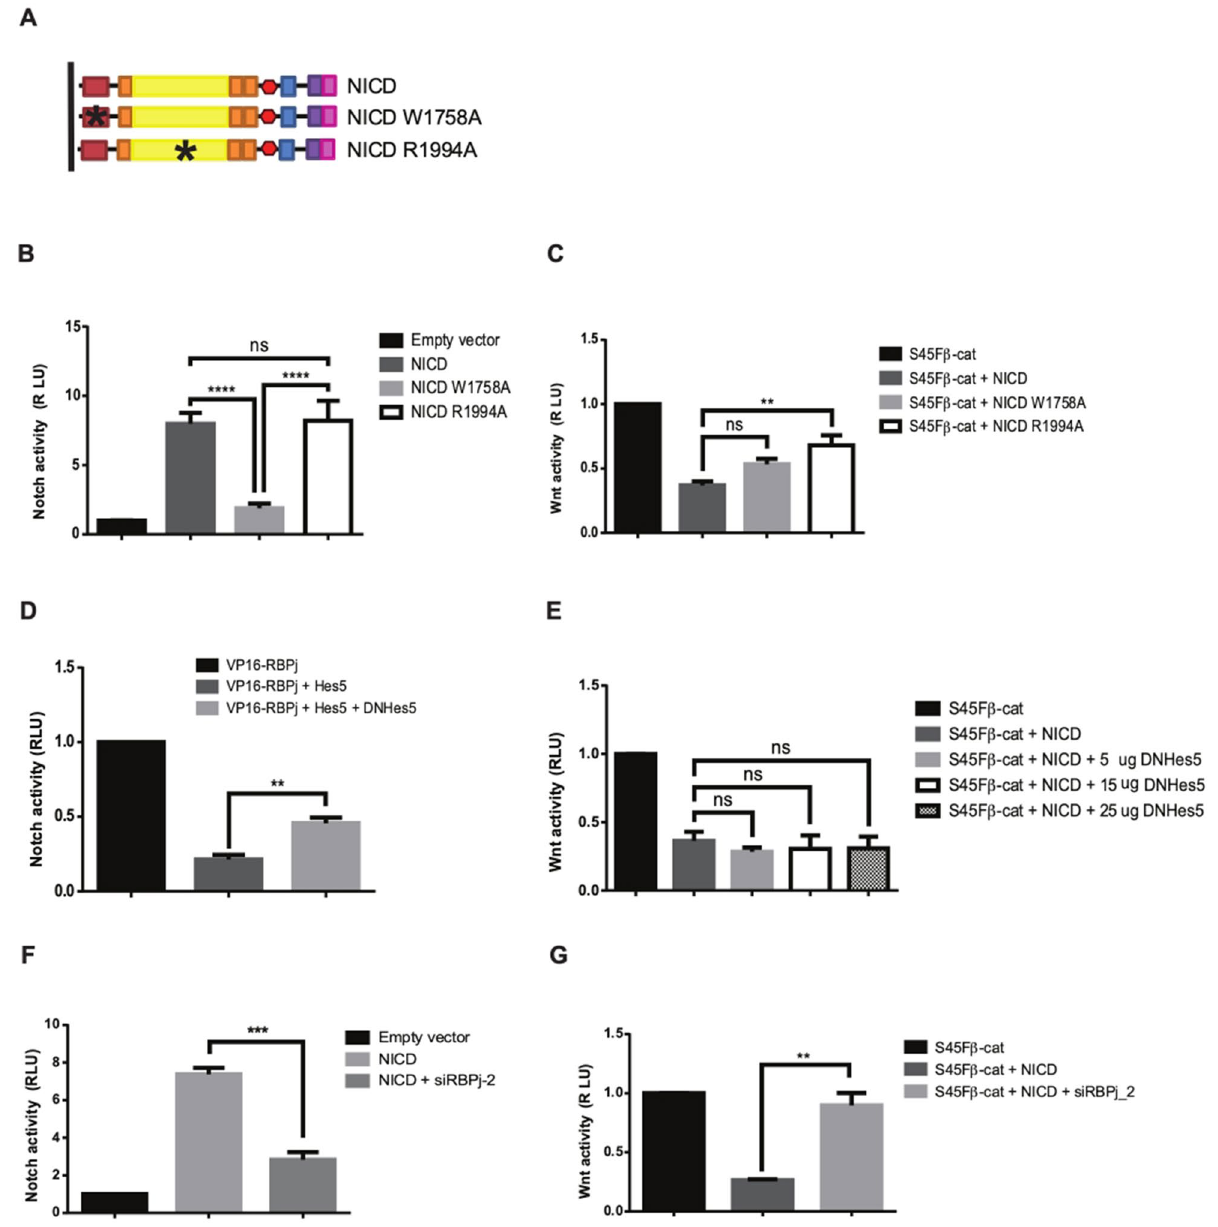
Figure 4. The inhibition of β-catenin-driven transcription by NICD does not require transcription of its downstream target genes. ( A ) Schematic showing the structure of the NICD, NICD W1758A and NICD R1994A constructs. ( B ) Introducing the W1758A mutation into NICD abolishes its ability to induce transcription of the Notch-dependent reporter gene p10xRbpj-luc. In contrast, the R1994A has little effect on NICD function. ( C ) Both NICD W1758A and NICD R1994A were able to reduce S45Fβ-catenin-driven transcriptional activity. ( D ) The repressor function of Hes5 is blocked by DNHes5. Expressing Hes5 with VP16-RBPj reduces the ability of VP16-RBPj to activate the pHes1-luc reporter plasmid. This inhibition of VP16-RBPj driven transcription was attenuated, as expected, by expressing a dominant negative form of Hes5. ( E ) DNHes5 is not able to eliminate the ability of NICD to inhibit S45Fβ-catenin-driven transcriptional activity. ( F ) siRNA silencing RBPj attenuates the ability of NICD to induce Notch signalling. ( G ) Inhibition of RBPj by siRNA blocked the ability of NICD to inhibit S45Fβ-catenin-driven transcriptional activity. HEK293T cells were transfected with p10xRbpj-luc or pHes1-luc ( B , D , F ) to monitor Notch signalling and pTCFAdTATA ( C , E , G ) to monitor Wnt signalling. Notch signalling was activated by expressing NICD ( B , F ) or VP16-RBPj ( D ). Wnt signalling was activated by expressing S45Fβ-catenin ( C , E , G ). Experiments were performed in triplicate. pRL-CMV was used as a transfection control and cells were lysed 48 h post transfection to determine luciferase activity. Data are presented as mean fold change (± SEM) in RLU (NS P > 0.05; ** P < 0.01, *** P < 0.001, **** P < 0.0001 one-way ANOVA and Tukey’s post-hoc test, N =